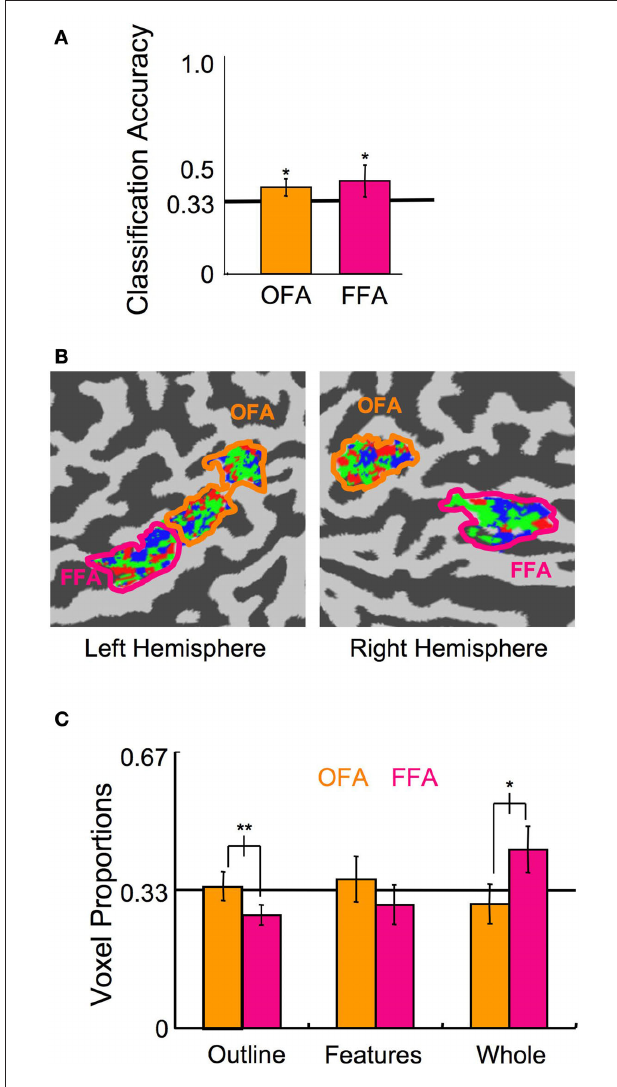
Figure 10 | experiment 3 results. (A) Classification of the stimulus category, ignoring the position (error bars, 95% c.i.). (B) A flat map of face-sensitive cortex from a representative subject showing the distribution of the categories to which each voxel maximally contributed. (C) Distribution of the proportion of voxels that maximally contributed to each of the three categories in the OFA and FFA (error bars, 95% c.i.). Asterisks indicate the level of significance for independent t -tests in (A) and paired t -tests in (C) (* p < 0.05, ** p < 0.01, *** p <